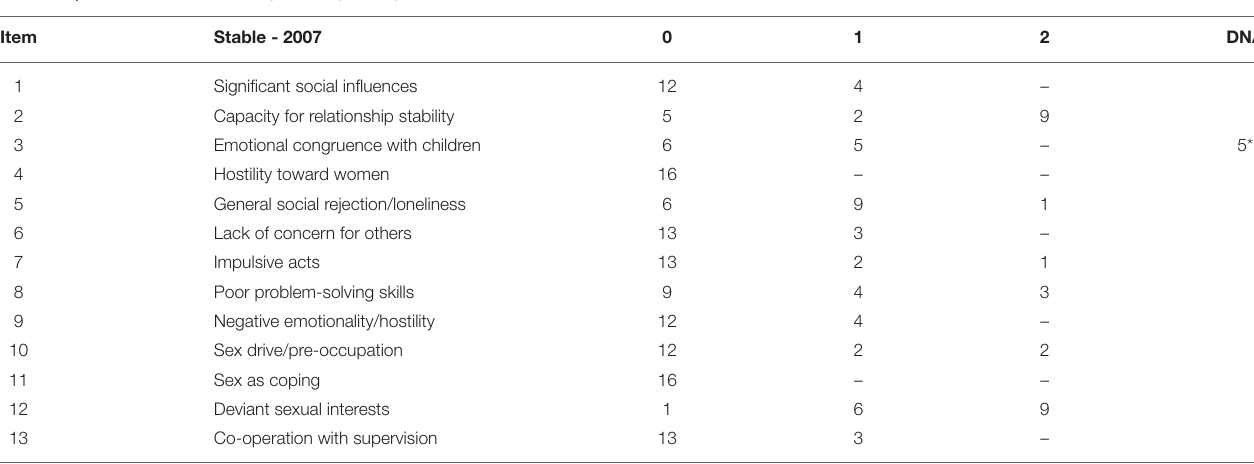
TABLE 3 | Risk assessment scores per item ( N = 16) on the